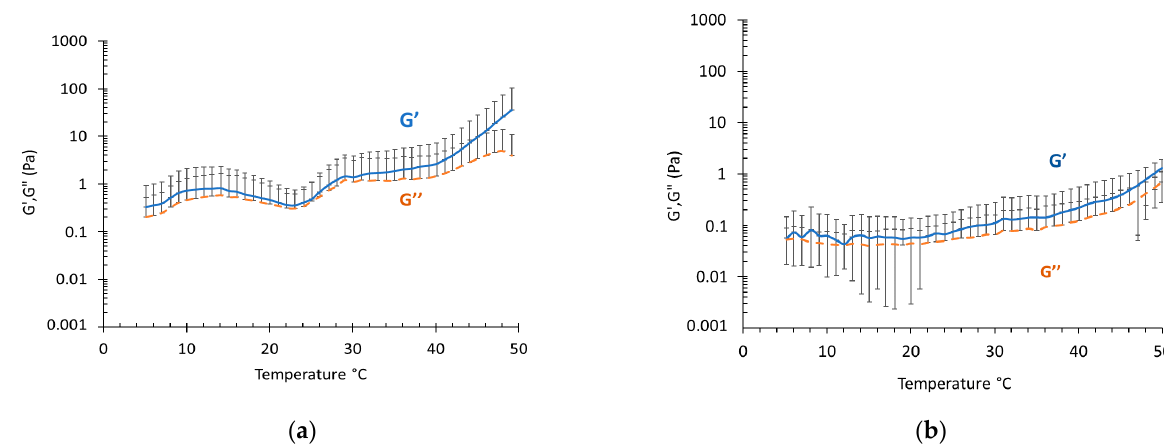
Figure 5. Evolution of elastic (G’, blue) and viscous (G”, orange) moduli for P11-MG ( a ) and P12-MG ( b ).